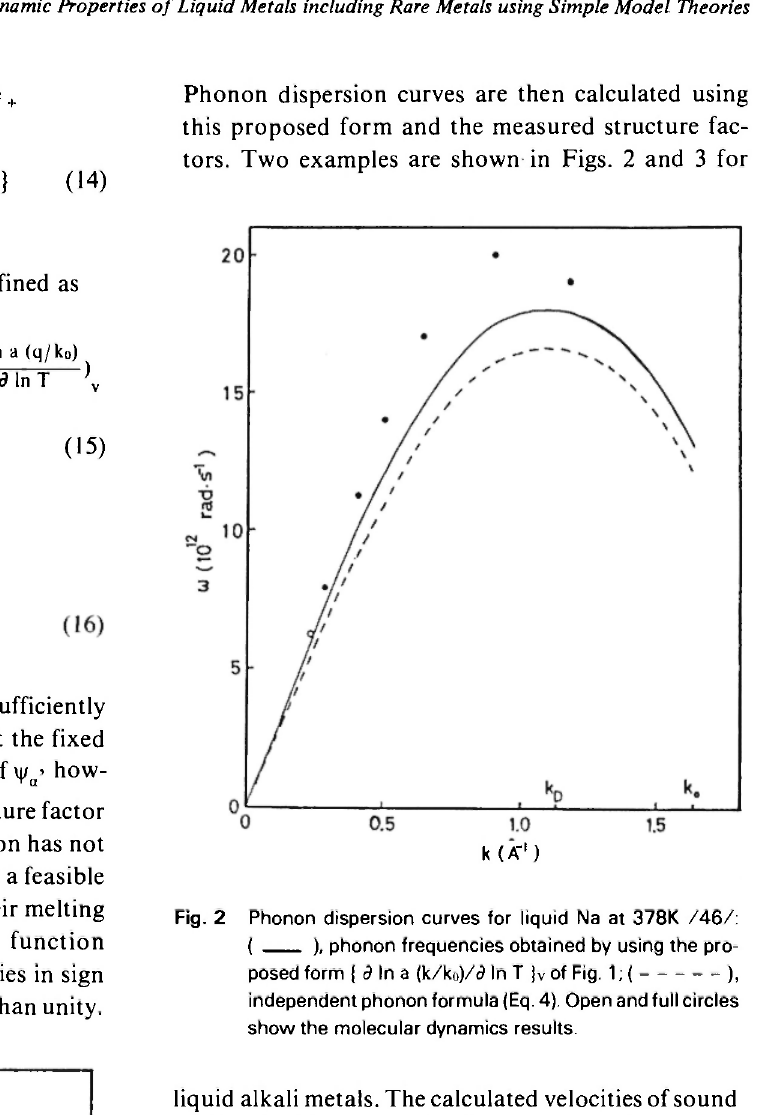
Μ A-') Fig. 2 Phonon dispersion curves for liquid Na at 378K /46/: ( ), phonon frequencies obtained by using the pro- posed form { d In a (k/ko)/<? In Τ | v of Fig. 1; ( ), independent phonon formula (Eq. 4). Open and full circles show the molecular dynamics results.